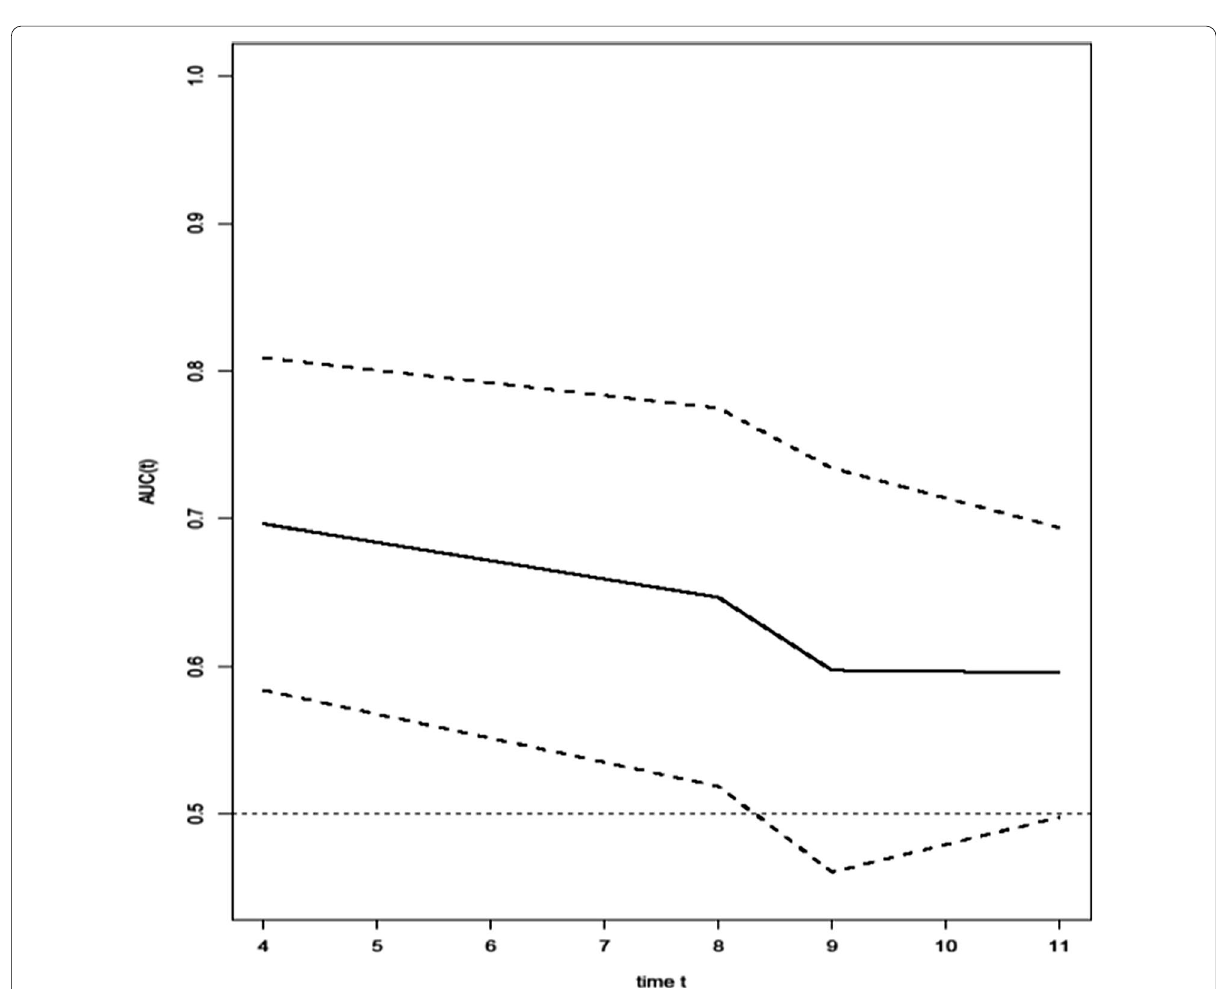
Fig. 1 Inverse probability of censoring weighting estimation of cumulative/dynamic time-dependent ROC curve for NT-proBNP patients with were zero for a low NT-proBNP patient but 5 times higher for a high NT-proBNP patient. The odds of severe status were statistically higher in those with high levels of NT-proBNP than in those with low levels ( P Furthermore, patients with high NT-proBNP levels were more likely to be admitted to the ICU ( P Other characteristics, such as gender, temperature, level of C-reactive protein (CRP), history of respiratory dis- ease (odds of having respiratory disease among Low NT- proBNP: 0.065; Medium: 0.072; High: 0.045), and cancer (odds of having cancer among Low NT-proBNP: 0.088; Medium: 0.047; High: 0.045) showed no significant dif- ference between the three groups with different levels of NT-proBNP (Table 1).